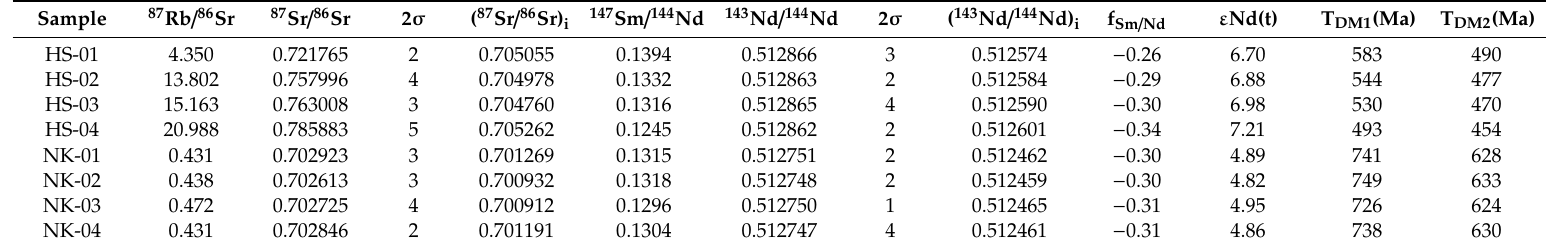
Table 4. Sr-Nd isotopic compositions of the Hongshan and North-Karamay granitoids.